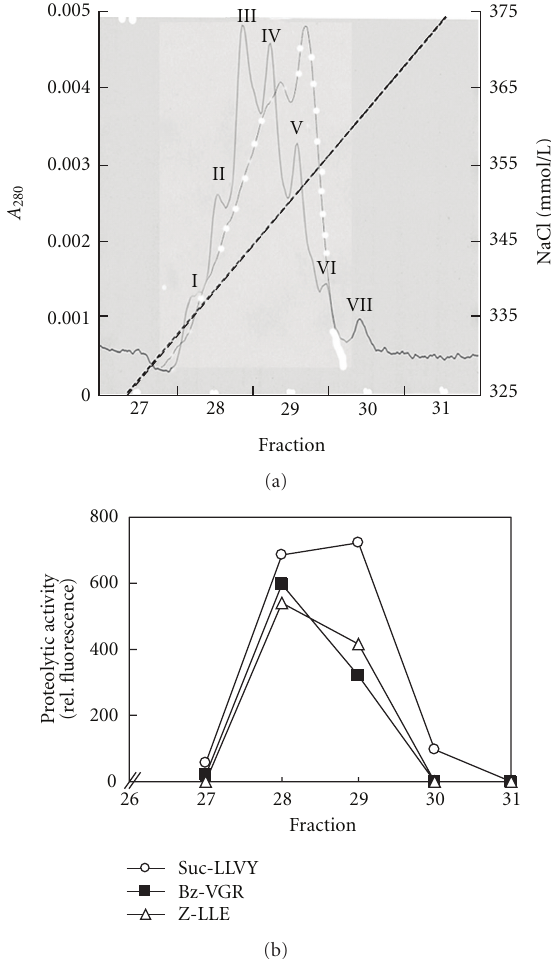
Figure 5: Subtype pattern of the extracellular alveolar proteasome of patients with ARDS (continuous line) and of plasma from healthy subjects (white points). (a) 20 μ g of 20S proteasome from pooled BAL supernatant of five ARDS patients were purified, subjected to chromatography on Mini Q, and separated into their subtypes by elution with increasing concentrations of NaCl. Sub- types detected by absorption at 280 nm are designated by roman figures (I–VII) according to the order of their elution from the column. All subtypes elute at NaCl concentrations (dashed line) between 330 and 370 mmolNaCl/L, and only this detail of the chro- matograms is shown. (b) All collected fractions of the subtype pat- tern chromatography of the extracellular alveolar proteasome of pa- tients with ARDS were measured by the highly specific proteasomal fluorogenic peptides Suc-LLVY-AMC (open points), BZ-VGR- AMC (black rectangle), and Suc-LLE-AMC (Z-LLE-AMC) (open triangle). Only in the fractions 28–30, proteasomal enzyme activity could be observed. Analysis of alveolar proteasome revealed a new proteasomal subtype pattern in the extracellular alveolar space of ARDS patients that di ff ers from that of healthy subjects’ plasma, suggesting that the extracellular alveolar proteasome in ARDS does not derive from